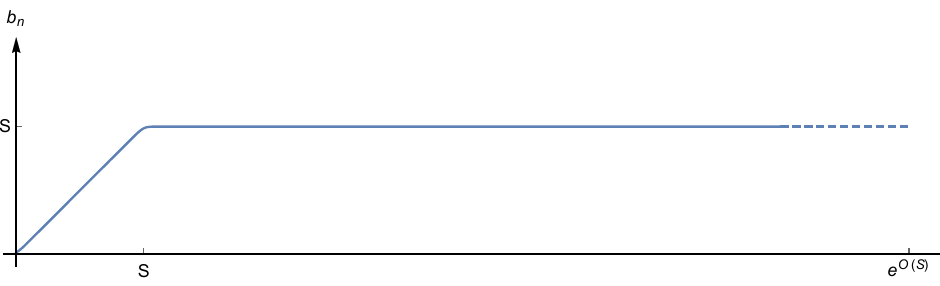
Figure 1 . Conjectured qualitative form of the Lanczos sequence for a fast scrambler with S degrees of freedom and Lyapunov exponent (cid:21) . It shows the linear growth characteristic of a fast scrambler and the long plateau extending up to the total dimension of the Krylov basis n max = e O ( S ) . The dotted line expresses our ignorance about the detailed structure of the